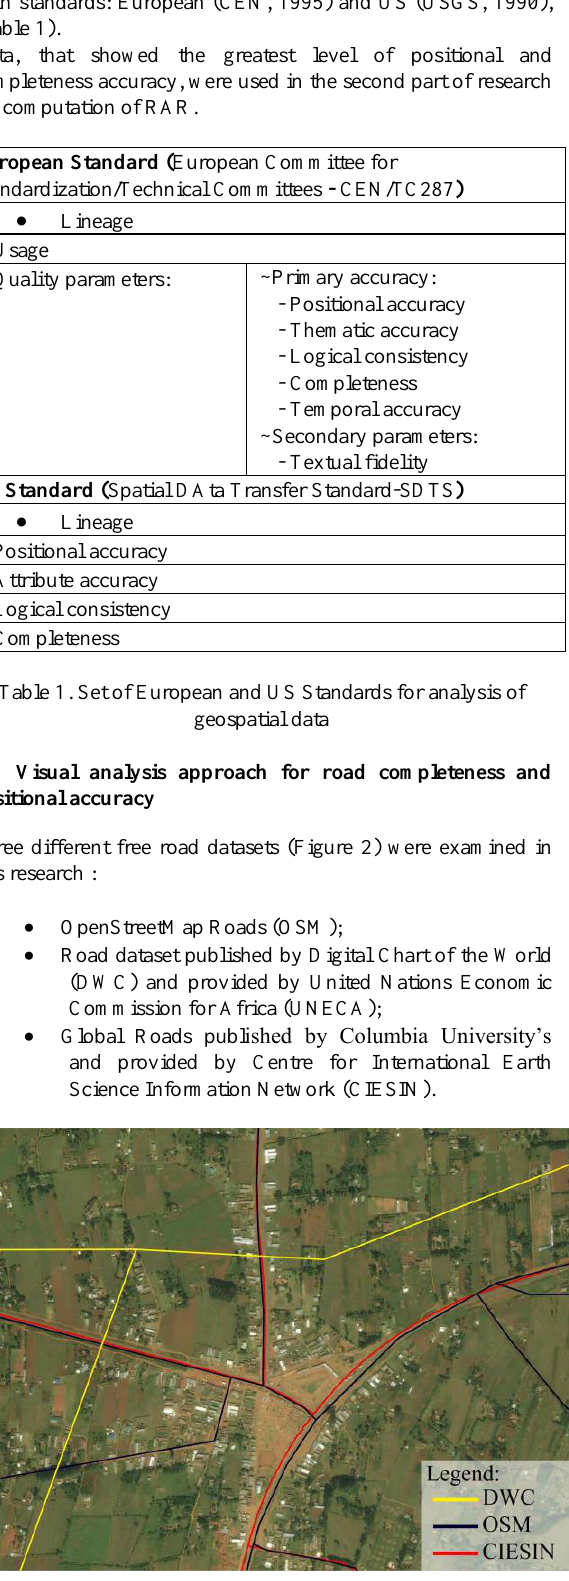
Figure 2. Randomly selected hexagon with three sets of road